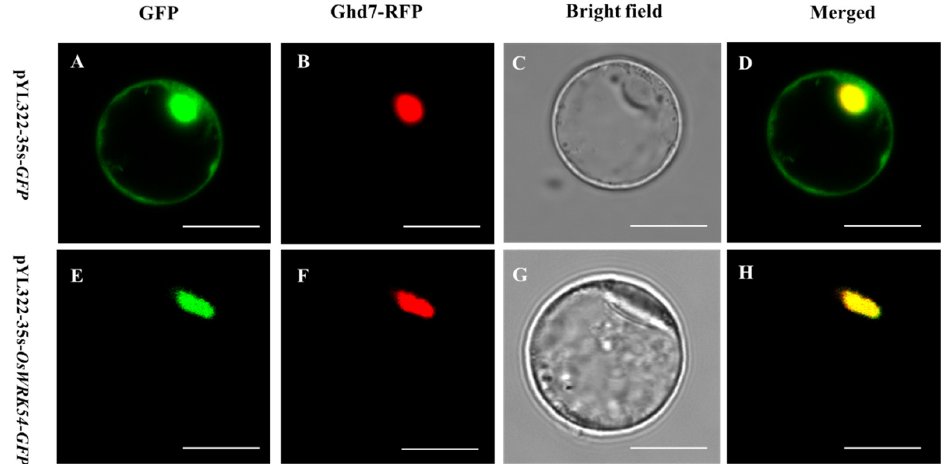
Figure 2. Subcellular localization of OsWRKY54. In rice leaf protoplast cells, OsWRKY54-GFP fusion or GFP alone was co-expressed with Ghd7-RFP, a nuclear marker. ( A – D ) show the localization of Ghd7-RFP and GFP. ( E – H ) show the localization of OsWRKY54-GFP and Ghd7-RFP. GFP, RFP, and merged RFP and GFP. Scale bar = 10 µ